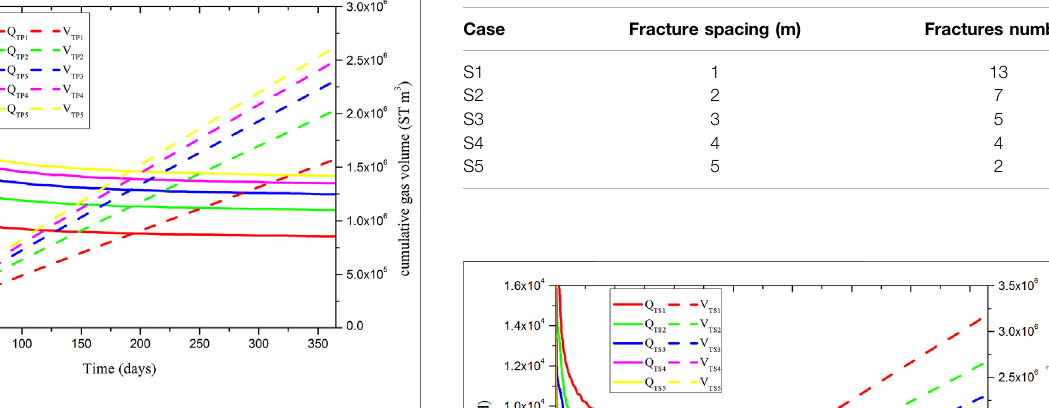
FIGURE 10 | Time-varying curve of gas production rate ( Q TD ) and cumulative gas production ( V TD ) in case of different fracture permeabilities.